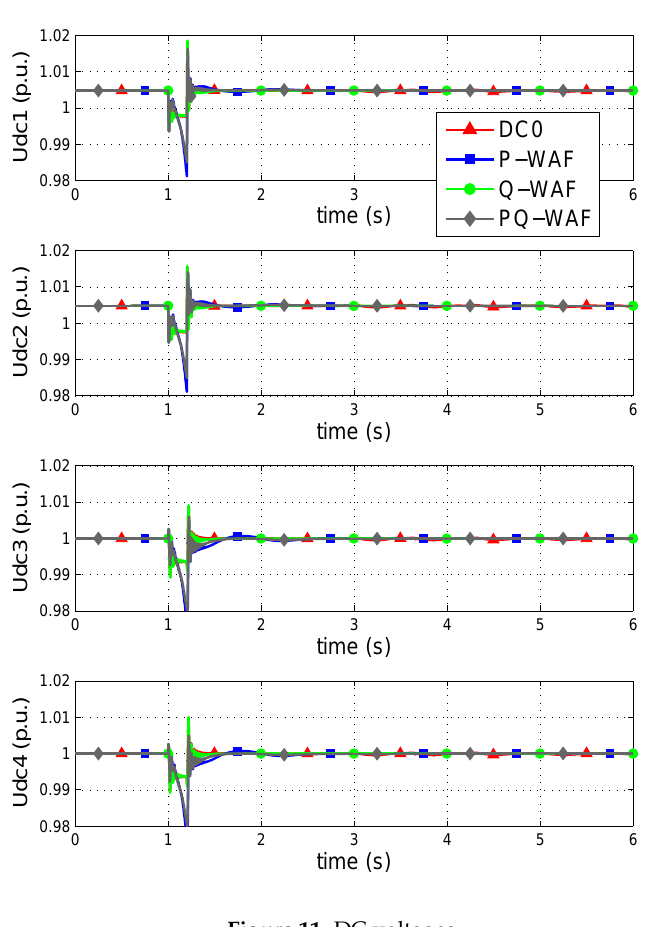
Figure 11. DC voltages.